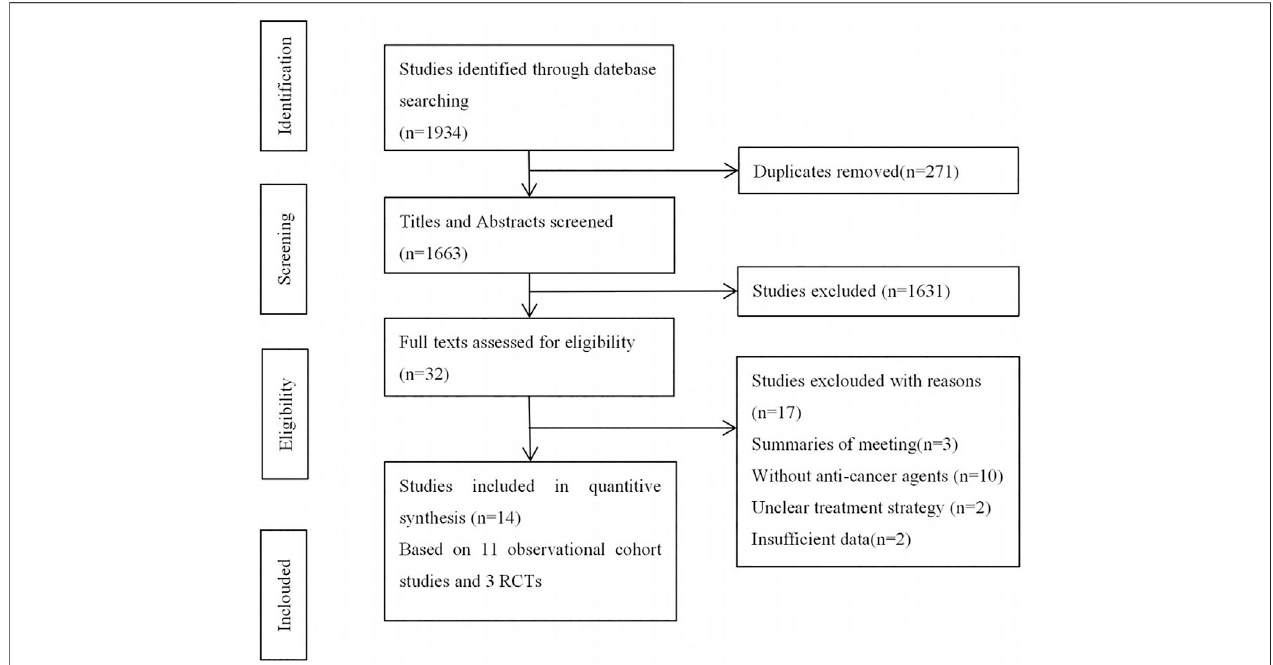
FIGURE 1 | Flowchart of study